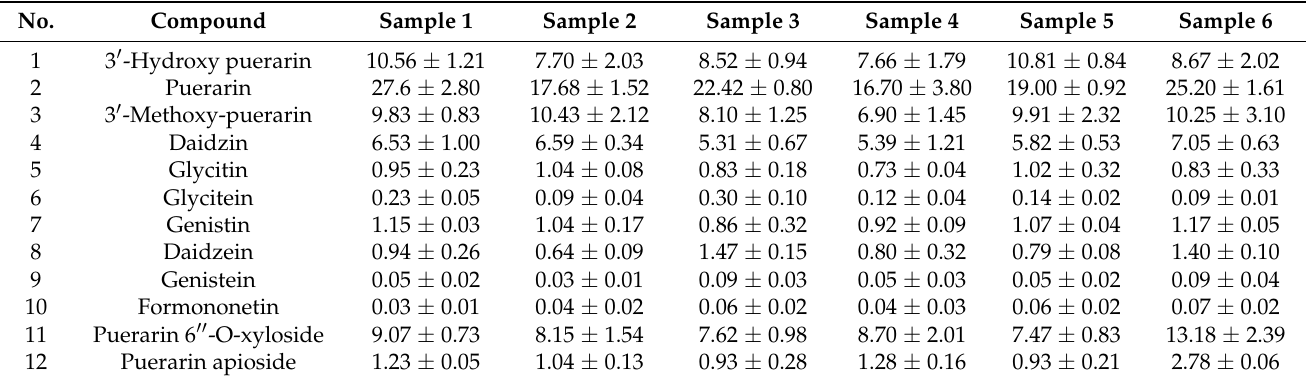
Table 3. The content of the 12 isoflavones compounds in 6 pueraria samples